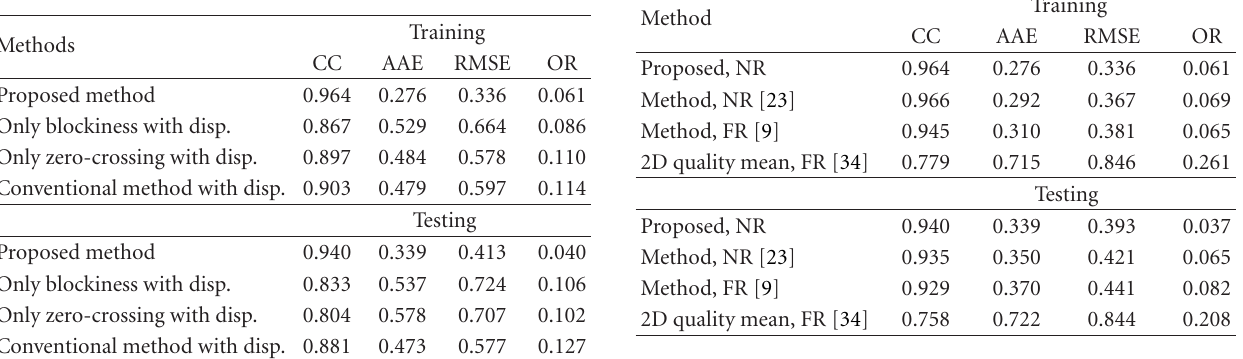
Table 3: Methods’ evaluation results for training and testing with disparity.